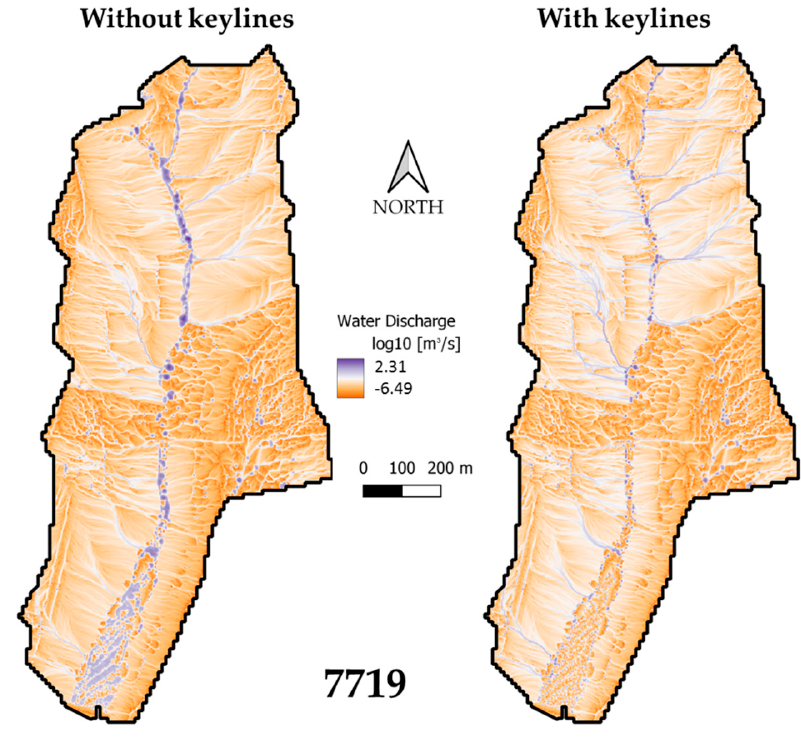
Figure 7. Water discharge (SIMWE) maps with and without the keylines for basin 7719.